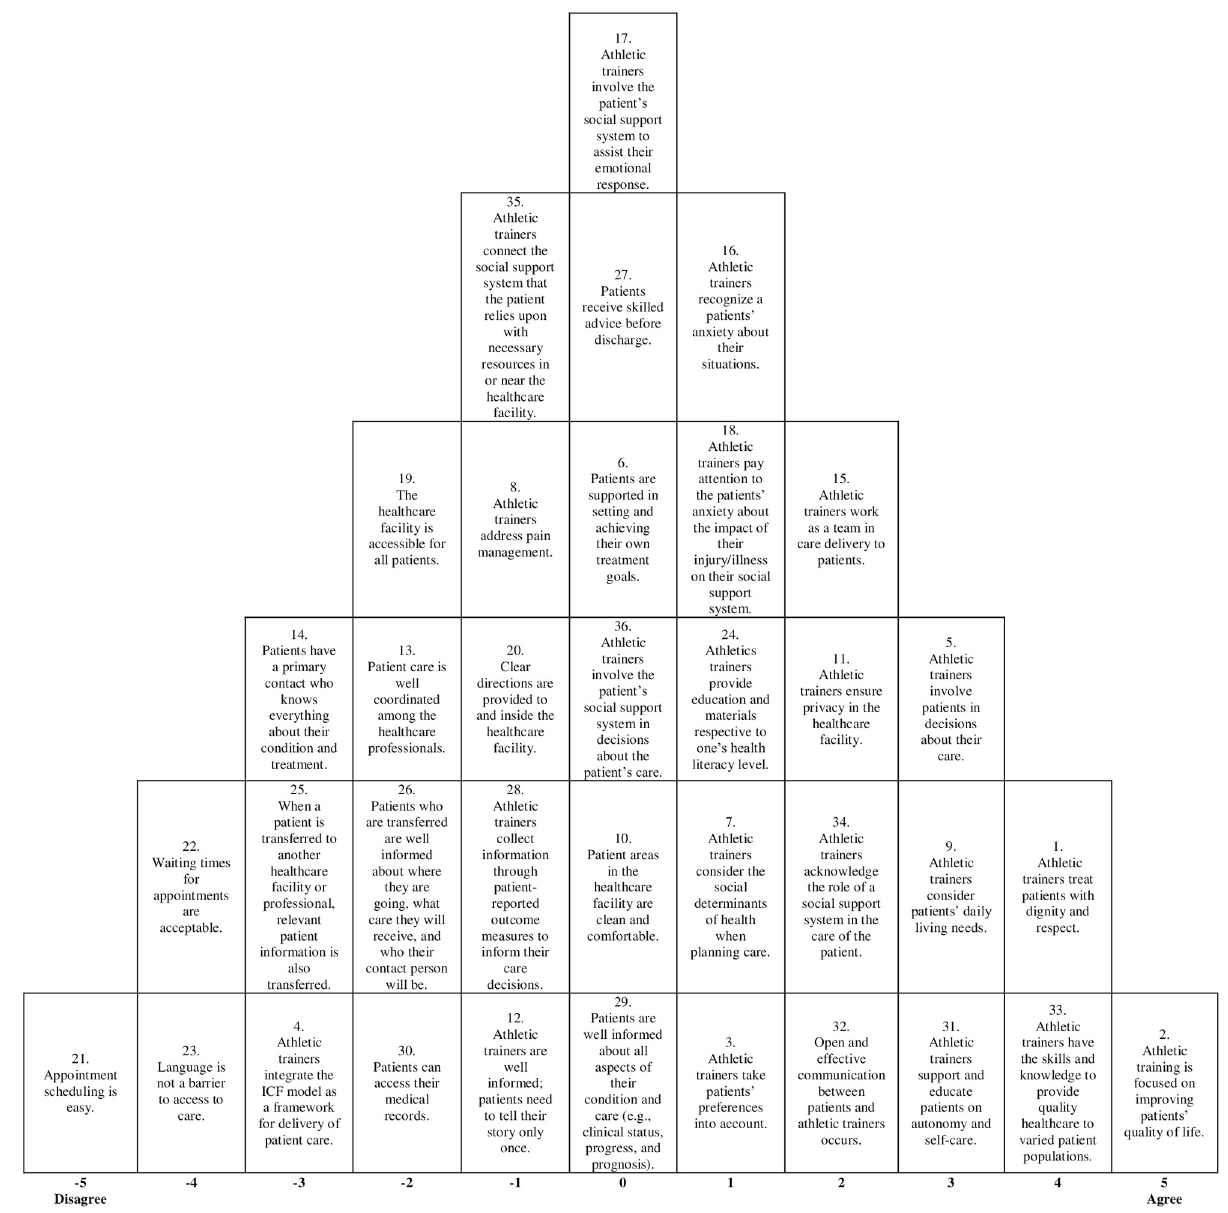
Fig 2. Composite Q-sort for viewpoint 2. The sort further describes the importance of the 36 PCC statements for viewpoint 2.